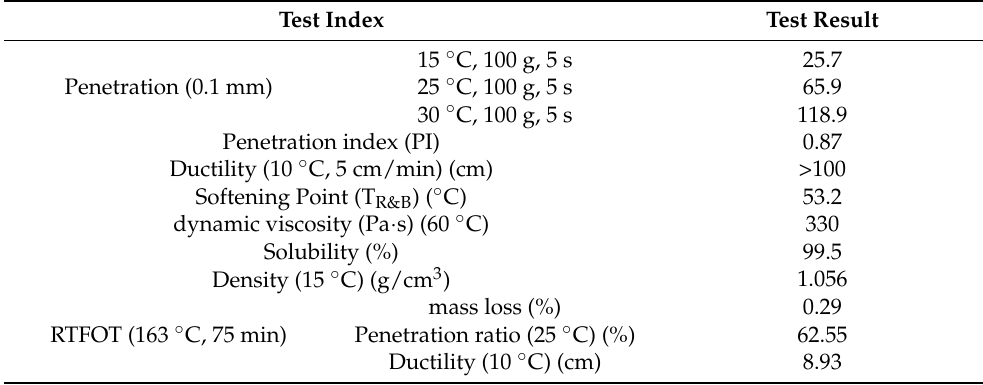
Table 1. Test results of main technical indexes of asphalt.